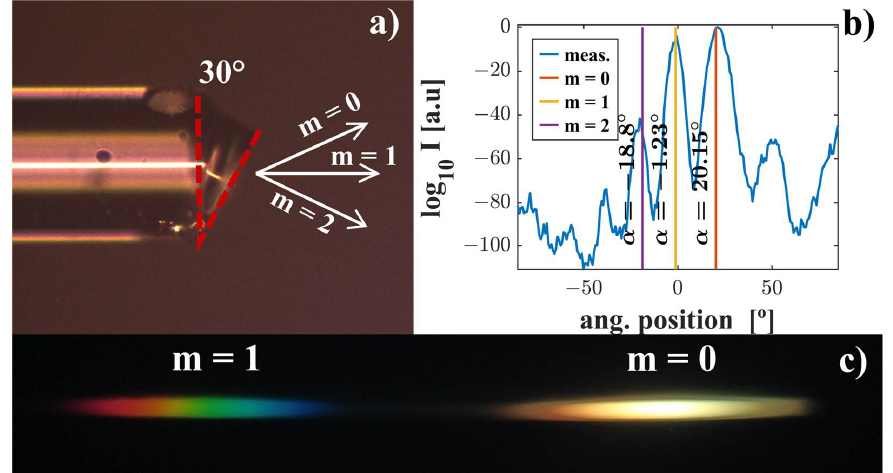
Figure 4. Microscopic side photo of fabricated structure marked with the angle of the prism and direction of diffraction orders ( a ). Far-field diffraction pattern at λ = 516 nm marked with the position of diffraction peaks calculated analytically ( b ). Zero-order and first-order diffraction spectra of supercontinuum source recorded by means of CCD camera ( c